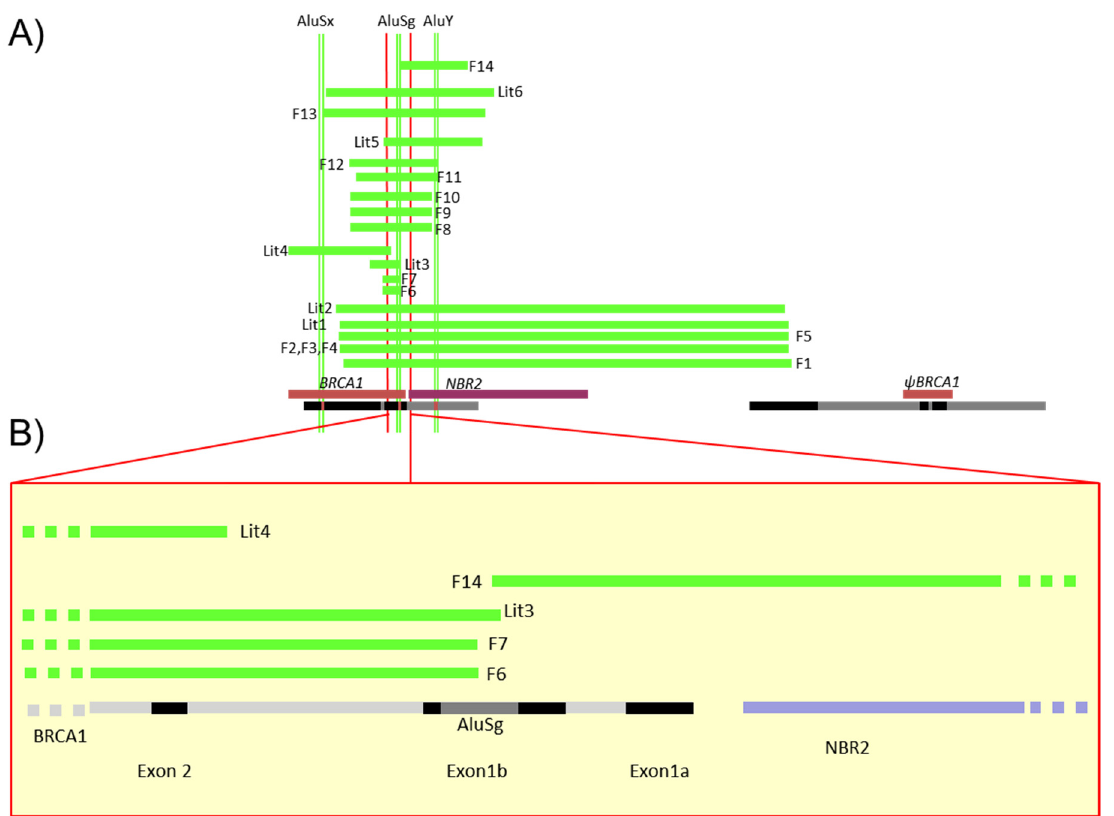
Figure 2. Schema of the different LGR detected in French families. ( A ) This diagram gives the description of Table 2 large deletions detected in the 5 ′ region described in 14 families. Green lines represent deletions detected in the French families (F1 to 14) or previously reported in the literature (Lit1 to 6); all segments are represented proportionally. At top, the Alu sequences (AluSx, AluSg, AluY) were also positioned precisely to identify specific breakpoints. At bottom, the NBR2 gene is in purple, BRCA1 and pseudoBRCA1 in brown and segmental duplication in black. ( B ) Focus on the 5 ′ region of BRCA1 including exon 2, non-coding exons 1a and 1b, the AluSg position, bidirectional promoter, and first exon of the NBR2 gene in black, BRCA1 introns in grey and NBR2 introns in purple.